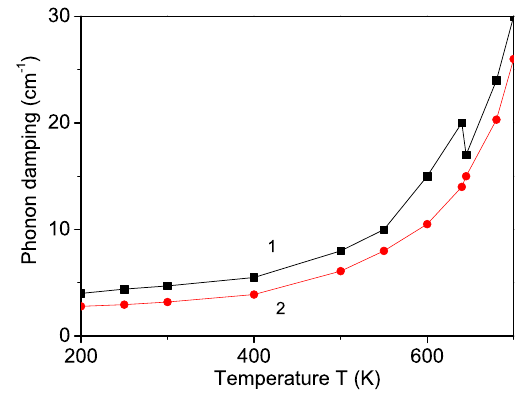
Figure 7. (Color online) Temperature dependence of the damping of the phonon mode ω = 149 cm − 1 in a YFO nanoparticle with N = 10 shells and different magnetic fields h : 0 (1); 50 kOe